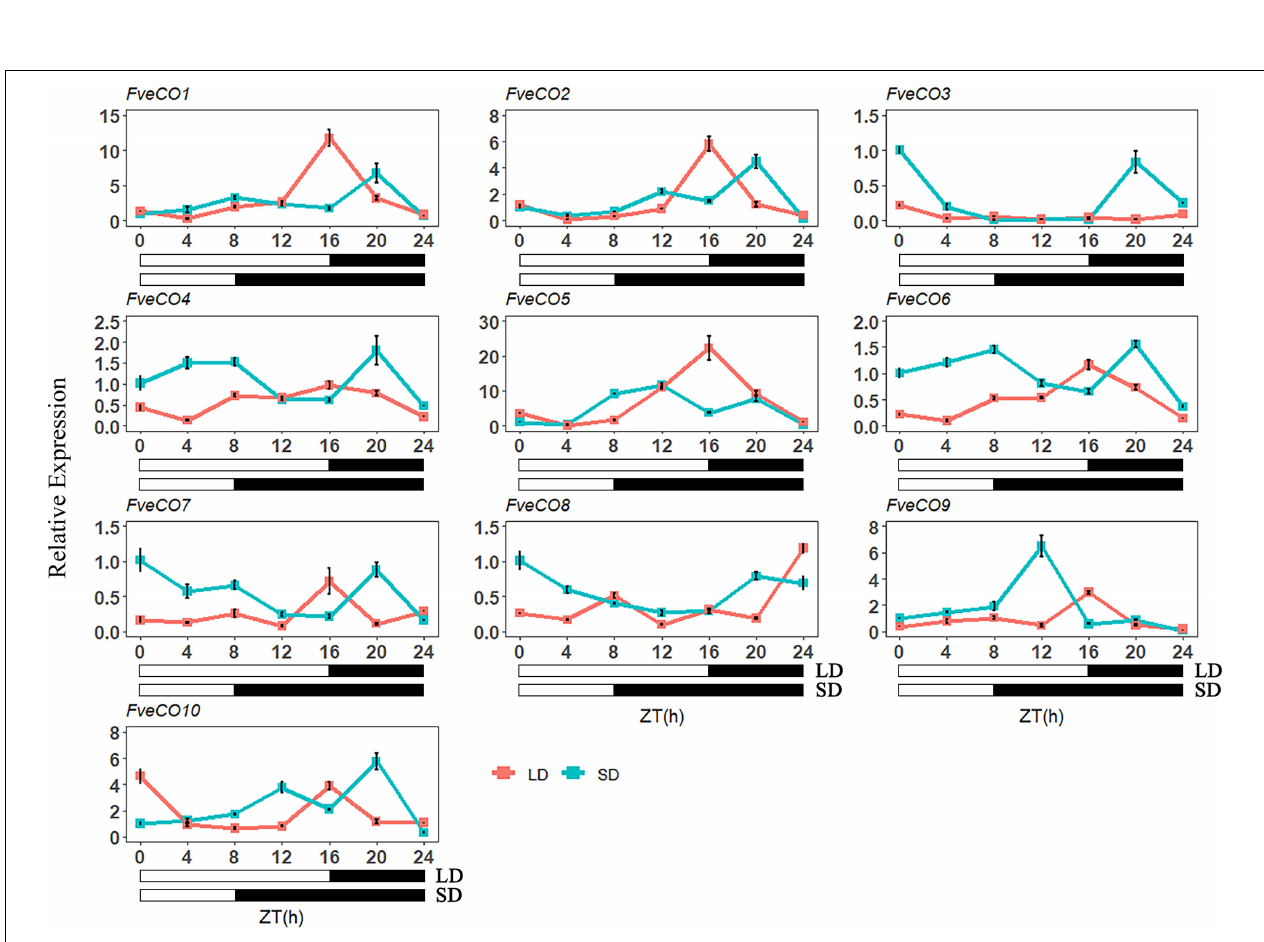
FIGURE 8 | Diurnal expression pattern of FveCOs under long-day (LD) and short-day (SD) conditions. The collection of samples was started at the beginning of the light phase (zeitgeber time 0, ZT0) and continued every 4 h over 24 h under LD (16-h light/8-h dark) and SD (8-h light/16-h dark) conditions. Each value is the mean ± SD of three biological